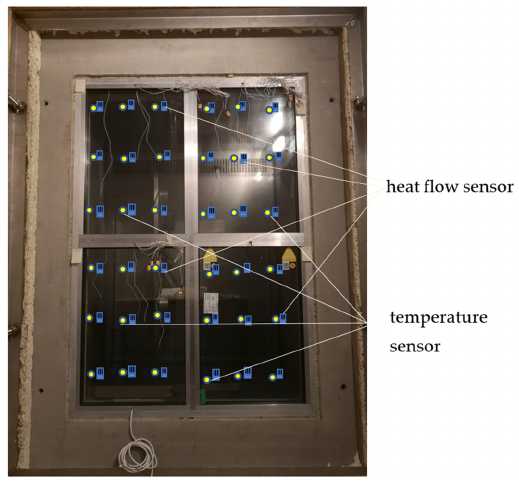
Figure 11. The studied windows installed in a climate chamber.